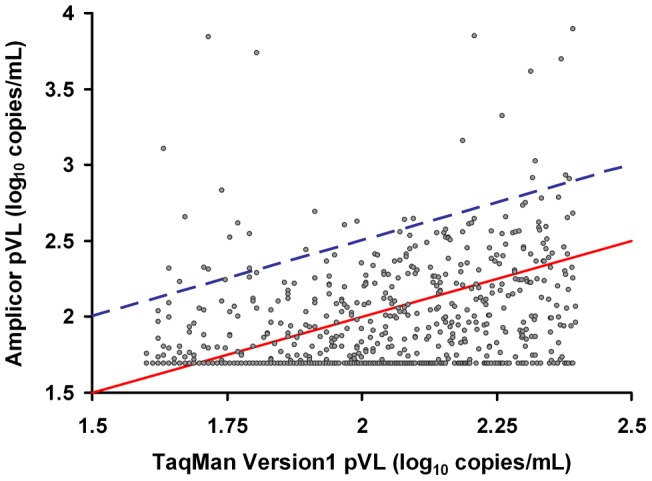
Poor concordance between TaqMan v1 and Amplicor v1.5 at low plasma viral load levels (40–250 HIV RNA copies/mL by TaqMan v1). Between October 2009 and April 2010 plasma samples from British Columbia with low-level viremia (40–250 copies/mL) by the Roche TaqMan v1 assay (N = 1198) were systematically re-tested by the Amplicor v1.5 assay. Poor concordance was observed between TaqMan v1 and Amplicor v1.5 results, with 82% of values falling below the line of identity (red solid line). Points above the blue dashed line are samples in which TaqMan v1 underestimated pVL by ≥0.5 log10 copies/mL relative to the Amplicor v1.5 assay.